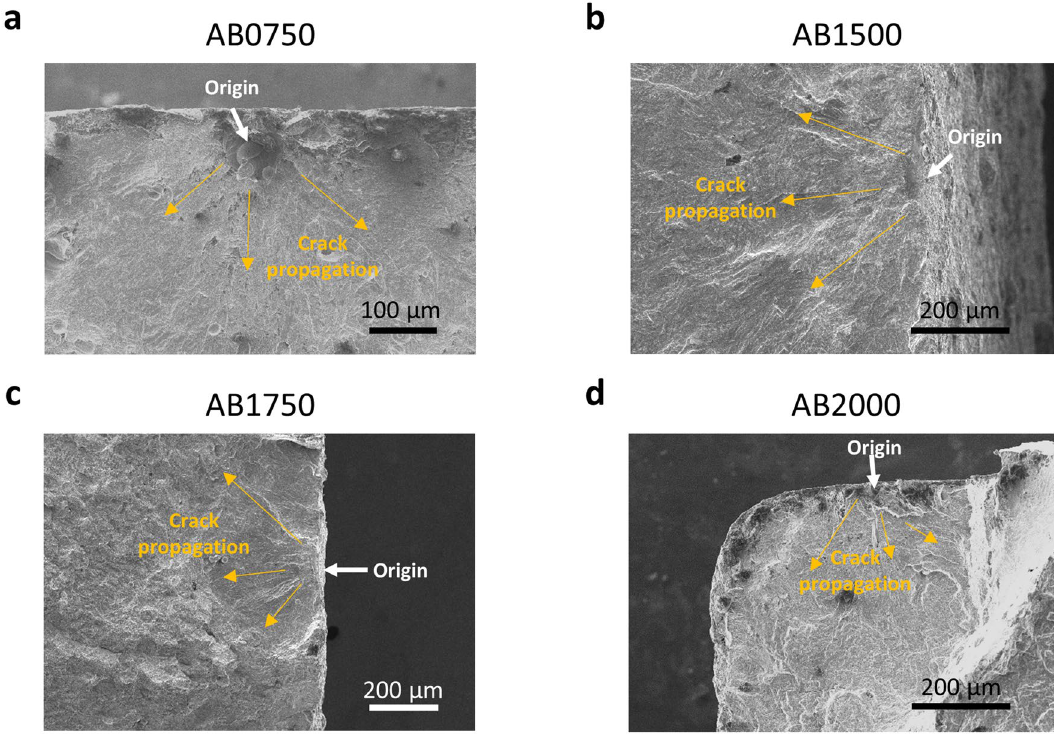
Figure 12. Fractography SEM images of AB samples. (a) For an AB750 sample (as-built sample printed at a speed of 750 mm/s), crack initiates from a pore located on the sub-surface. (b) For an AB1500 sample, crack initiates from the surface. (c) For an AB1750 sample, crack initiates from the surface. (d) For an AB2000 sample, crack initiates from the